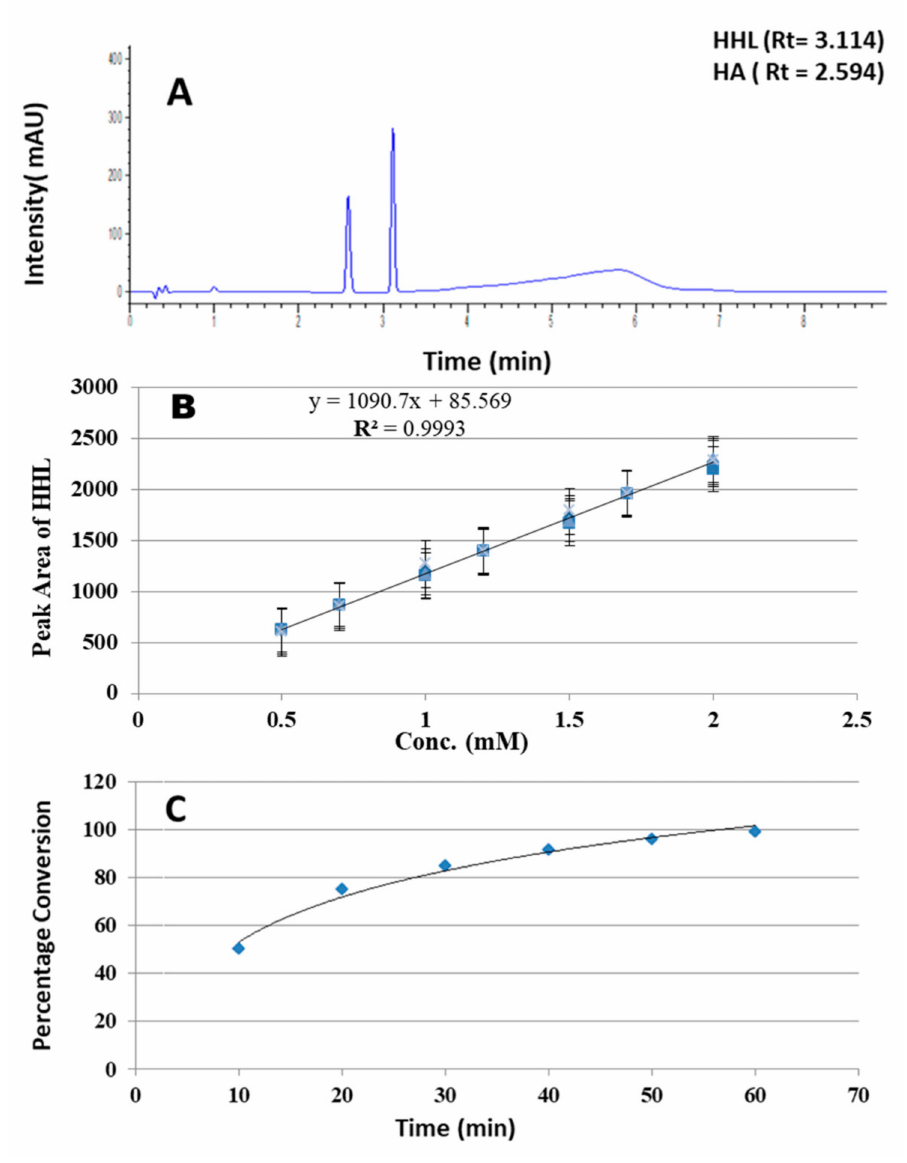
Figure 1. ( A ) UPLC-DAD chromatogram of HHL and HA. ( B ) Calibration curve of HHL. ( C ) ACE assay with different time